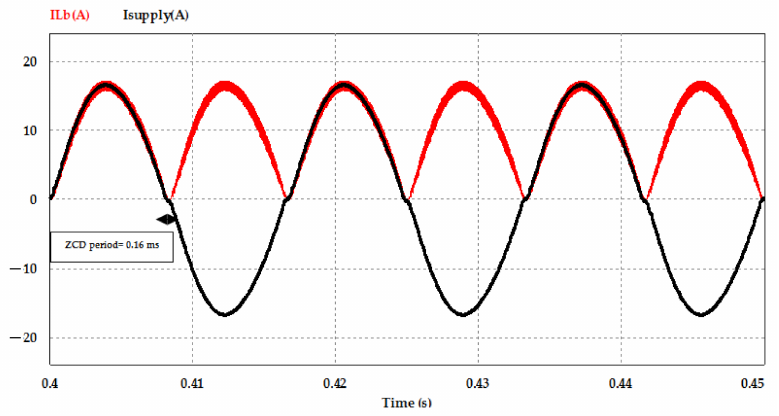
Figure 29. Waveforms of the inductor and supply currents with the proposed IP current